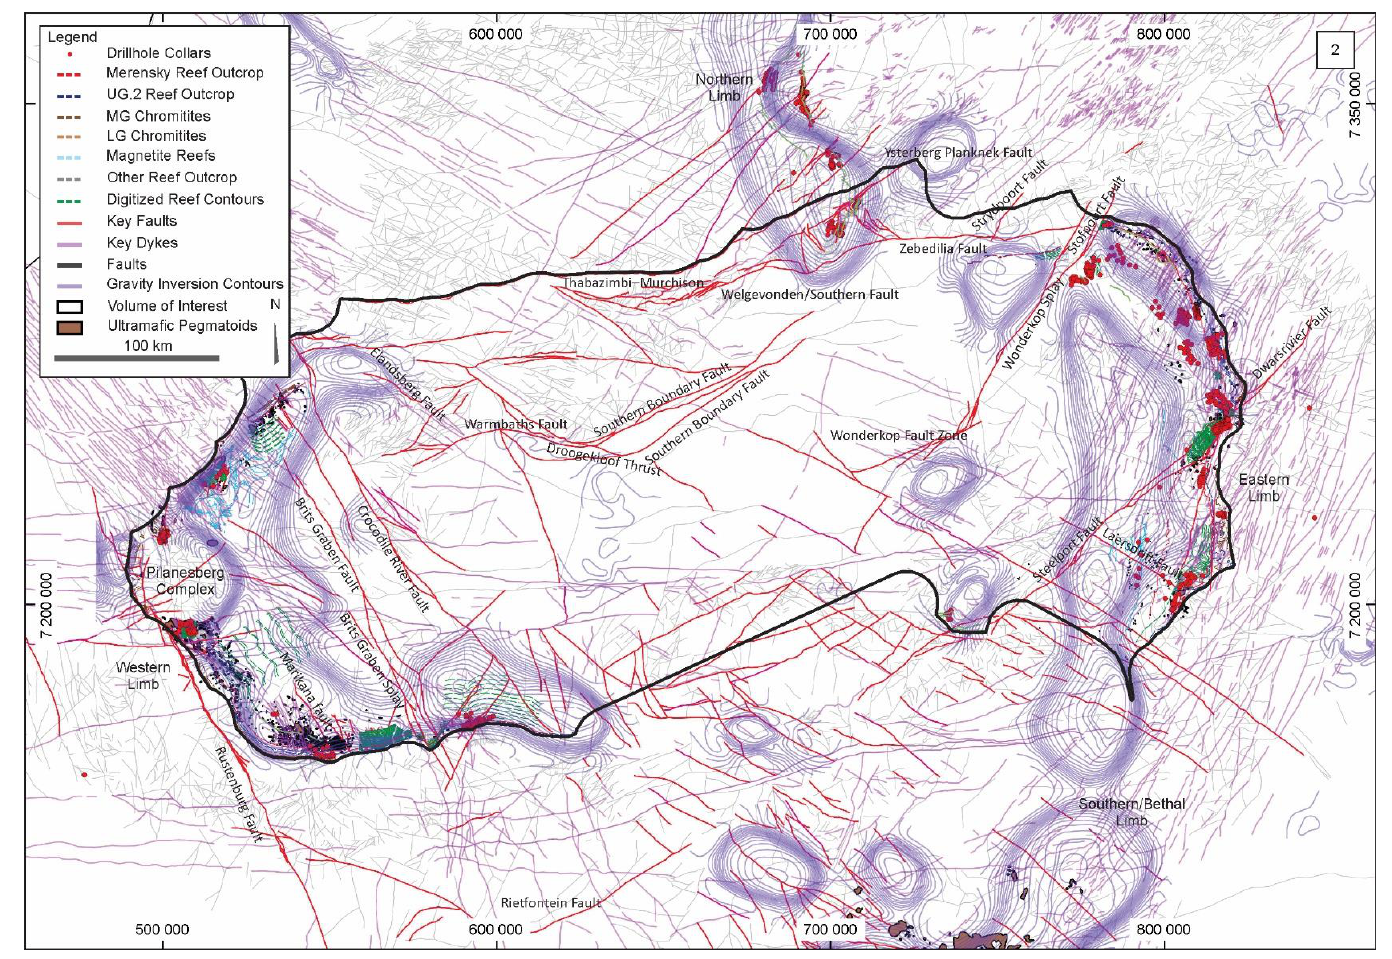
Figure 2. Boundary of the Volume of Interest and data distribution. Notable features include: (1) North-up reverse faulting along the Thabazimbi-Murchison Lineament (TML), Zebediela, Welgevonden/Southern, Bobejaanswater Fault systems; (2) SSE-directed thrusting along the Droogekloof Thrust, Boschpoort Fault/ Thrust and Southern Boundary Fault system; (3) Lack of dome development within the Western Limb.